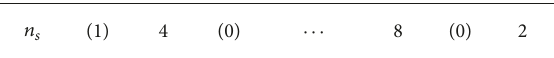
Figure 9: The solution representation of a single station near the